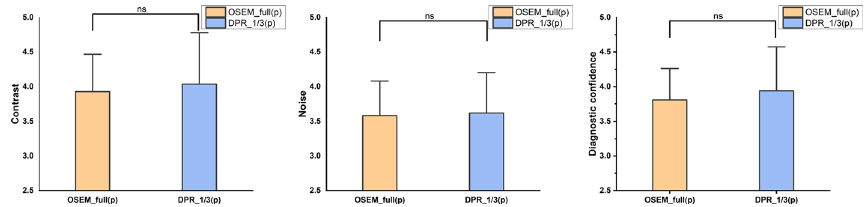
Fig. 5 Visual assessment of the image contrast, noise and diagnostic confidence between DPR_1/3(p) images and the reference. There was no significant difference found in all three perspectives. ns, no significant